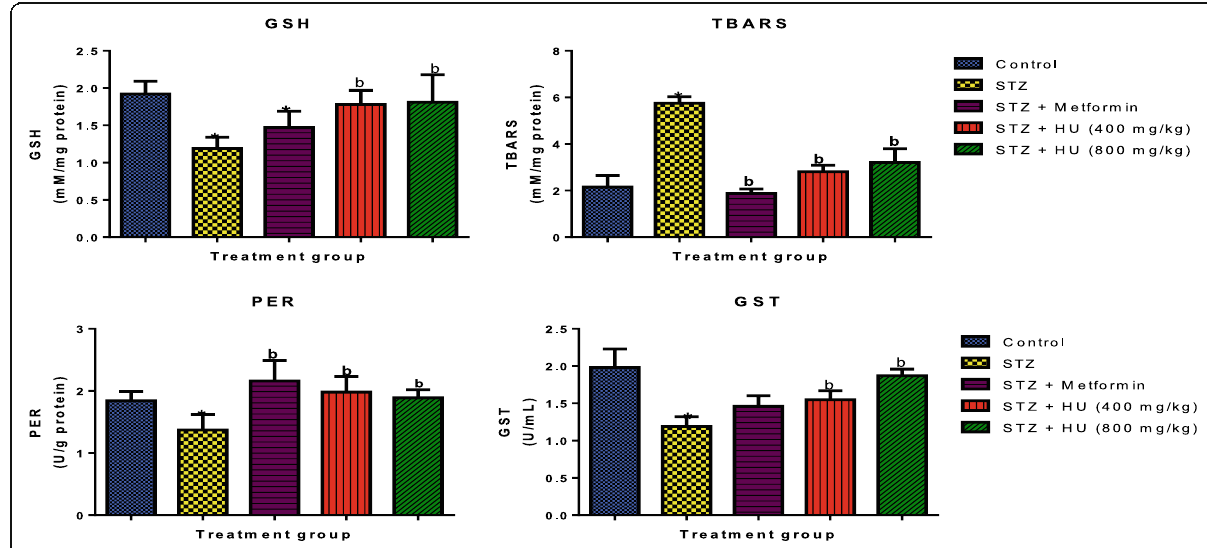
Fig. 1 Effect on oxidative markers in the liver. Superscripts * a b represent values that are significantly (p < 0.05) different from negative control, metformin treated group and positive control respectively. GSH, TBARS, PER, GST, STZ and HU represents reduced glutathione, thiobarbituric acid reactive substances, peroxidase, glutathione-s-transferase, streptozotocin and Hunteria umbellata